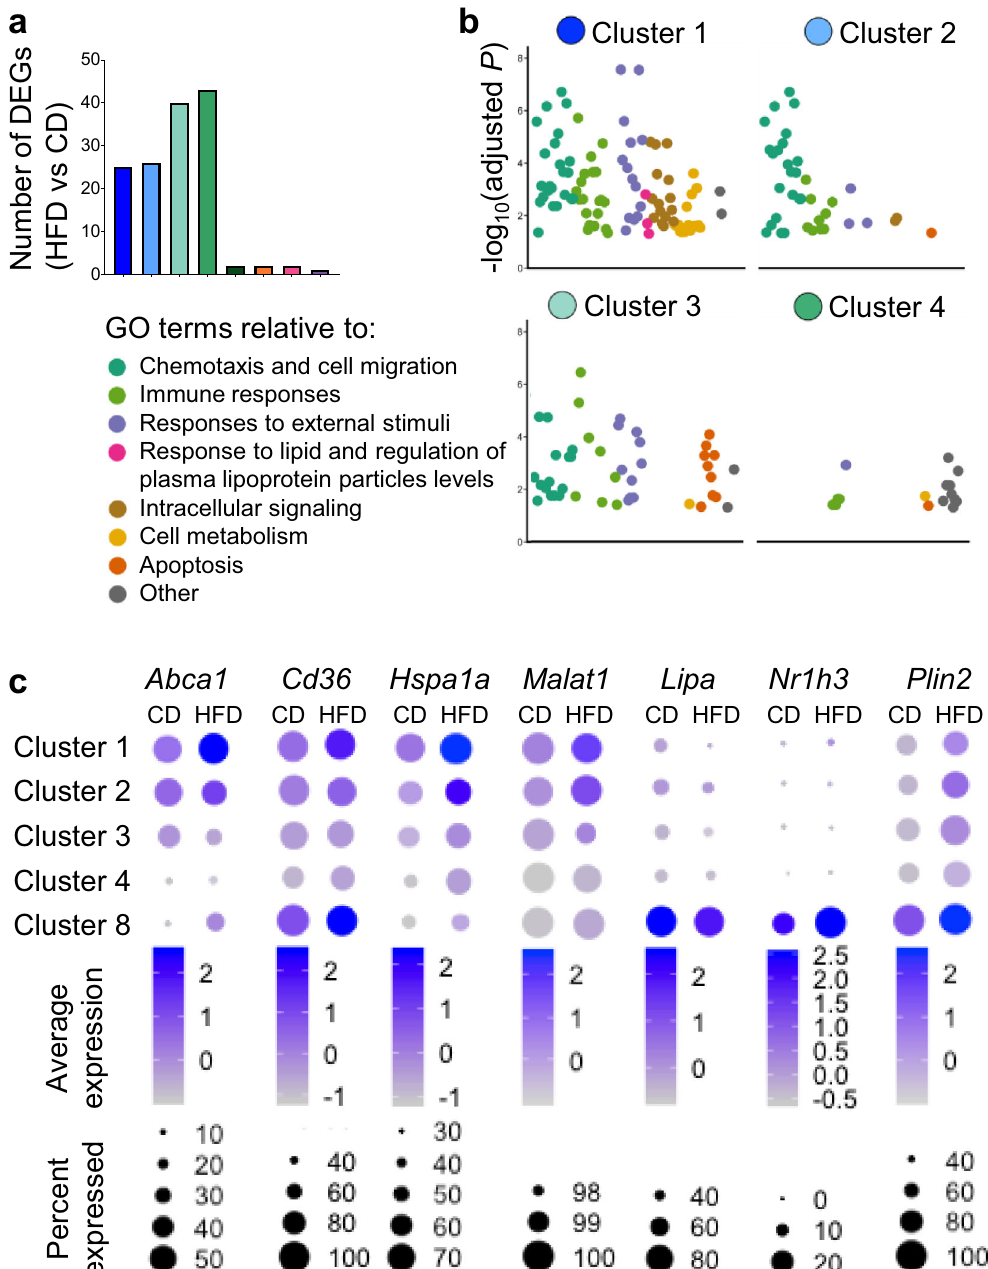
Fig. 5 Rapid metabolic adaptation of Lyve1 + Tim4 + ATMs to HFD ingestion. a Bar graph showing the number of DEGs between HFD and CD in the 8 ATM clusters. b Pathway analysis on DEGs induced in ATMs from Cluster 1 to Cluster 4 from mice fed overnight with HFD compared to mice kept on CD. Scatter plots show gene ontology (GO) terms categorized per color into families for Cluster 1 to Cluster 4. c Density plots showing average gene expression and percentage of cells expressing gene in Clusters 1, 2, 3, 4, and 8 in mice kept on CD and mice fed overnight with